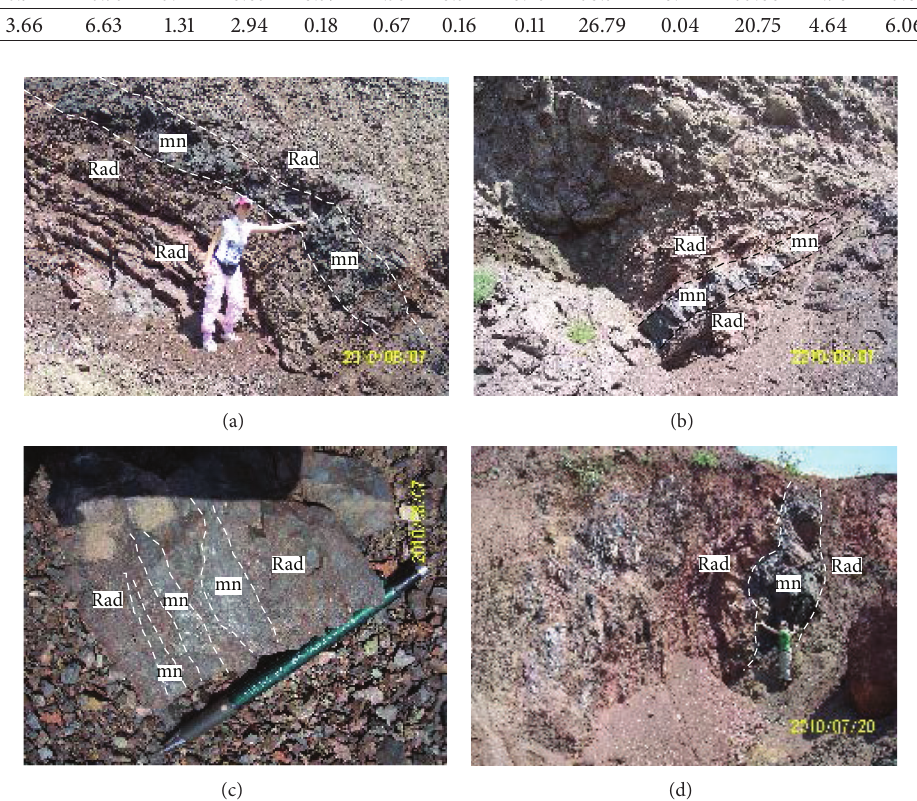
Figure 2: Laminated, banded ((a), (b), (c)) and lenticular forms (d) in the ore bodies (mn: manganese; rad: radiolarite).